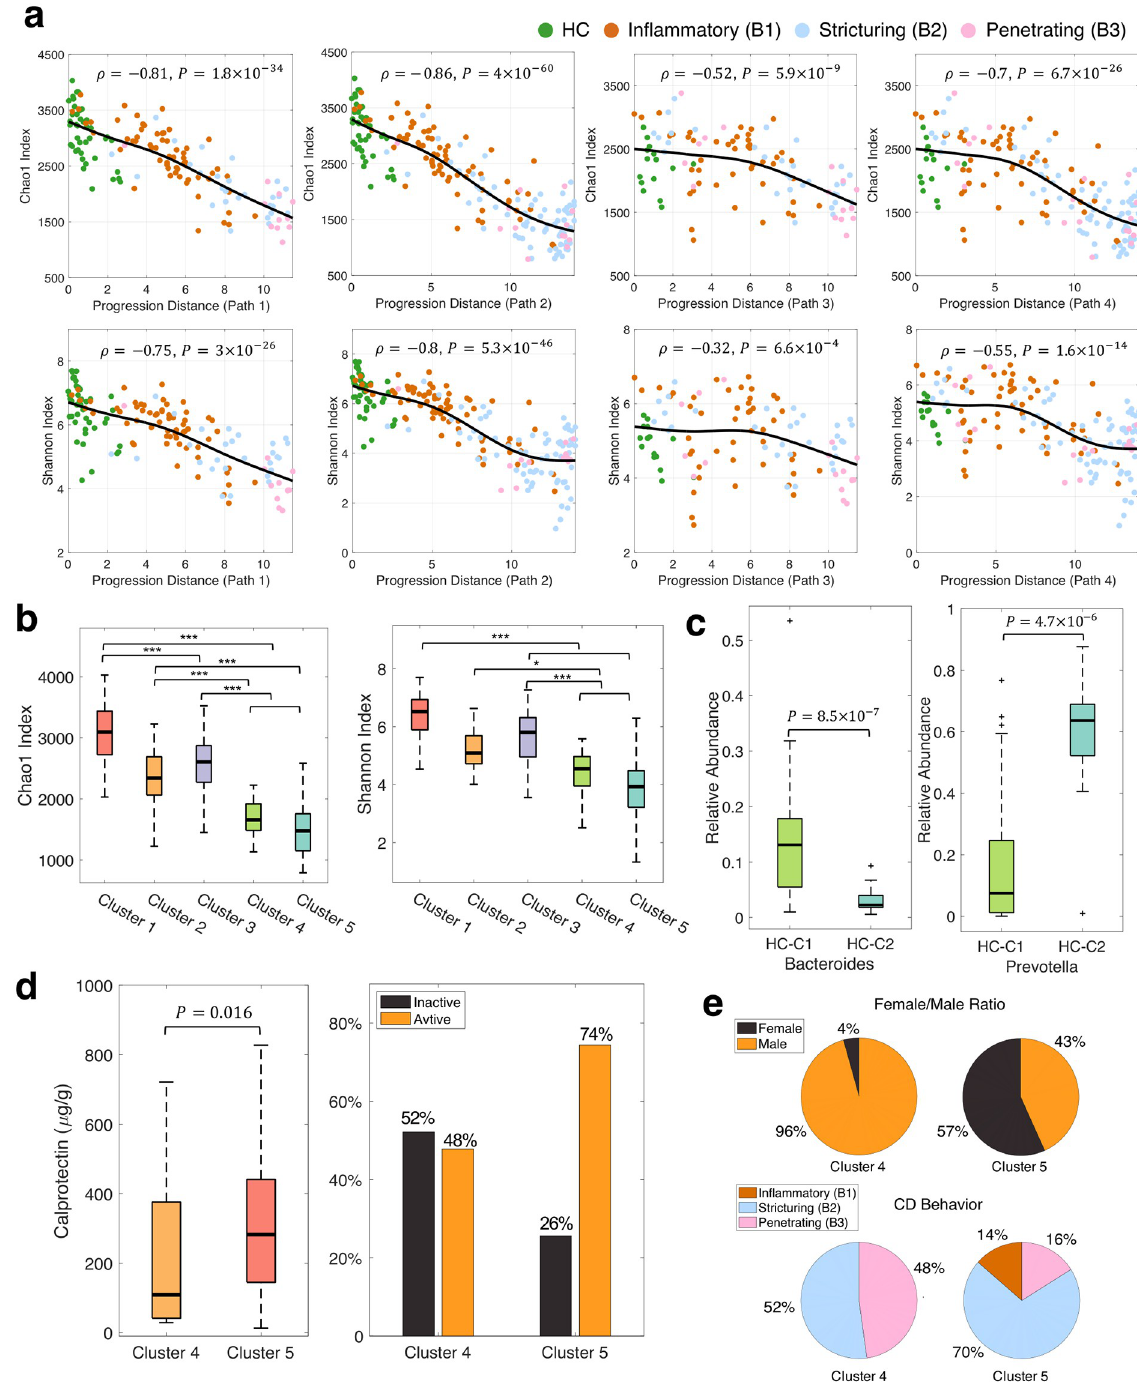
Fig 3. Changes in microbiome alpha diversity along identified progression paths and clinical characteristics of healthy states and disease endpoints. ( a ) Spearman’s rank correlation analysis of alpha diversity as measured by Chao1 index and Shannon index along the four identified progression paths (see Fig 2D). To aid in visualization, each sample was annotated by its clinical behavior. ( b ) Comparison of alpha diversity of five detected clusters. The asterisks indicate the levels of significance determined by ANOVA. � : p -value < 0.05, �� : p -value < 0.01, ��� : p -value < 0.001. Also see S3 Table. ( c ) Enterotype analysis of the HC samples in Cluster 1 (HC-C1) and Cluster 2 (HC-C2). HC-C1 and HC-C2 correspond to the enterotypes driven by Bacteroides and Prevotella , respectively. ( d - e ) Comparison of clinical characteristics of patients in two disease endpoints (i.e., Clusters 4 and 5). Cluster 5 contained a significantly higher proportion of patients with active inflammation (fecal calprotectin > 150 μ g/g) compared with Cluster 4 ( p -value = 0.016, χ 2 test). Clusters 4 and 5 exhibited significantly different female-to- male ratios and CD behavior compositions ( p -value < 0.01, χ 2